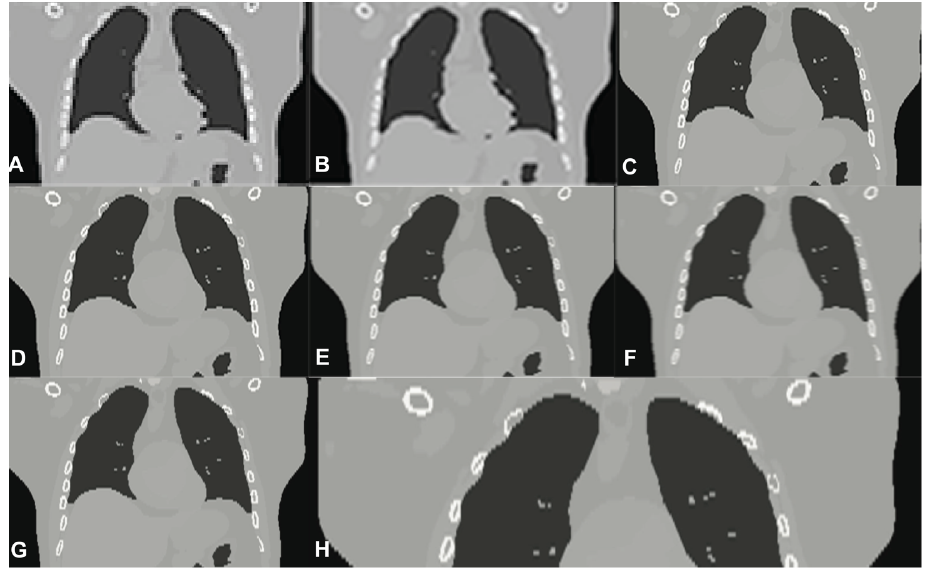
Figure 6. CT low-resolution vs. Super-Resolution Images. ( A ) LR input; ( B ) B-spline Cubic interpolation; ( C ) Non-Rigid Multi-Modal 3D Medical Image Registration Based on Foveated Modality Independent Neighbourhood Descriptor [25]; ( D ) Enhanced deep residual networks for single Image Super-Resolution [13]; ( E ) Image SR using very deep residual channel attention networks [14]; ( F ) Residual dense network for image SR [15]; ( G , H ) the presented algorithm (the right one exposes details). (The tests were performed using 4096 Projection lines/Coefficients and the ATA reconstruction